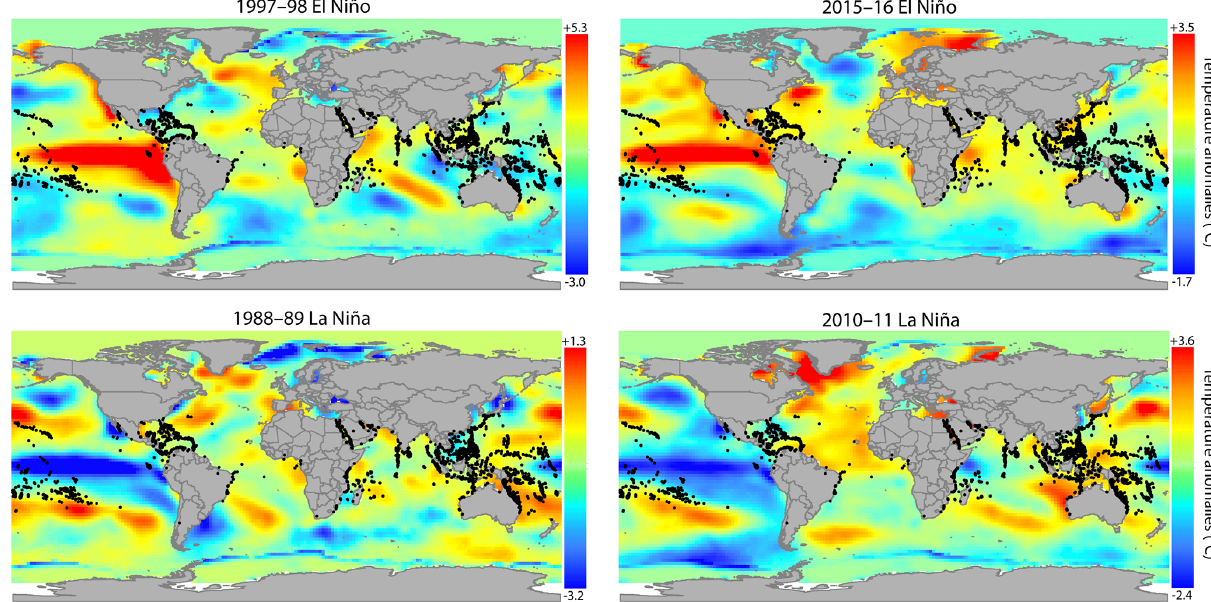
Figure 4. Thermal anomalies associated with two of the strongest El Niño events (1997–1998 and 2015–2016) and La Niña events (1988– 1989 and 2010–2011) in recent history. Black points on the maps indicate the locations of coral reefs. The imagery was created with data from NOAA’s Smith and Reynolds Extended Reconstructed Sea Surface Temperature, Level 4 monthly dataset (V5) using NASA’s PO.DAAC